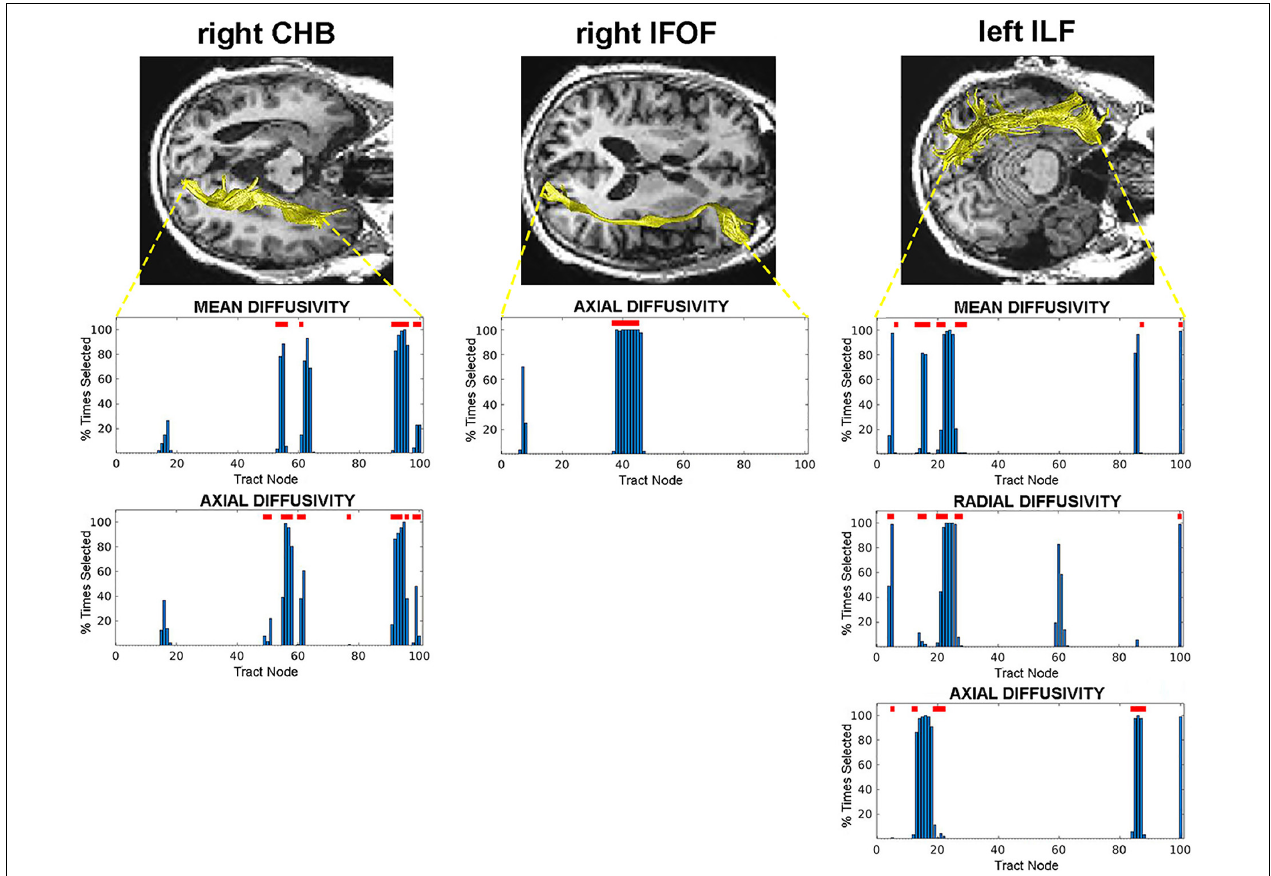
FIGURE 2 | Tract nodes selected by the RFE procedure for tracts with predictive value. Top images display tracts from one participant overlaid on structural images in axial view. Bottom graphs are histograms displaying the percentage of times each tract node was selected by the RFE procedure. Red lines above bars indicate nodes where significant C vs. NC group differences were detected. Left: right CHB tract; Middle: right IFOF tract; Right: left ILF